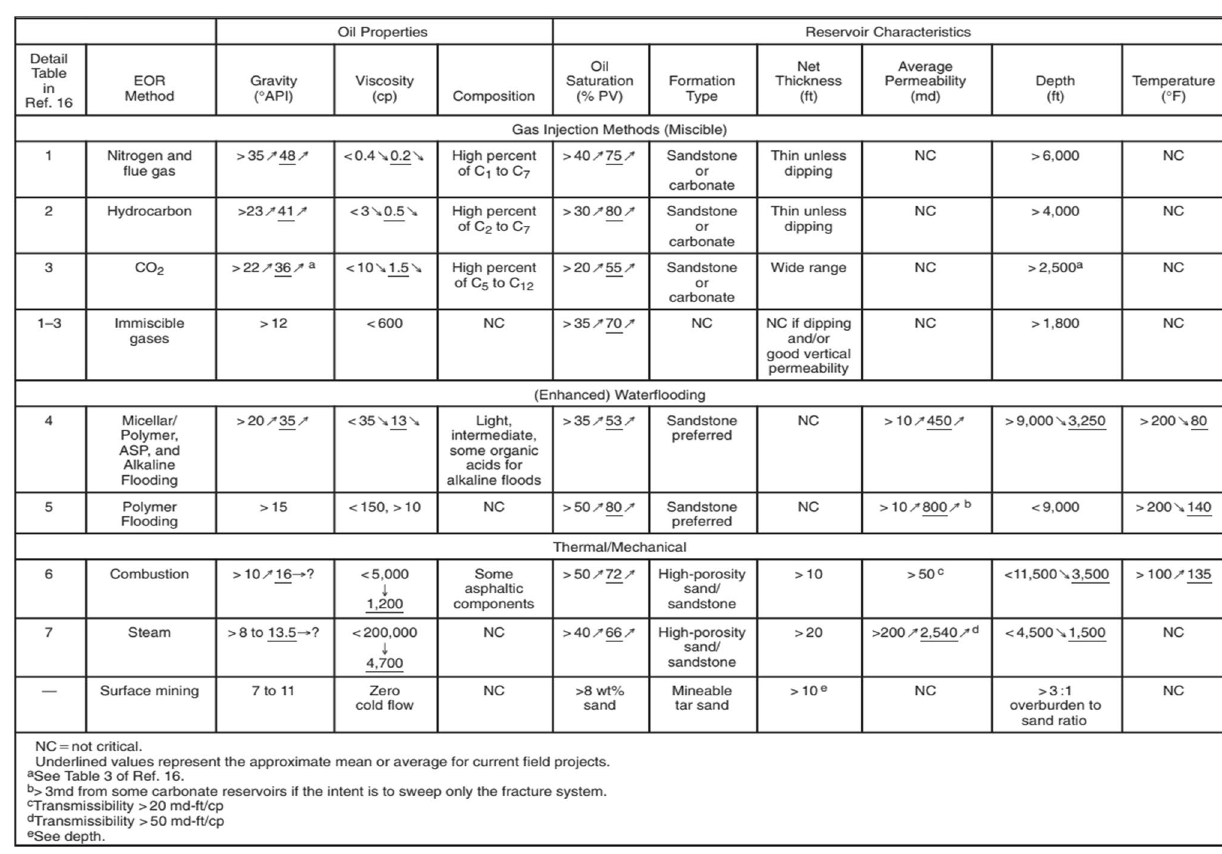
Fig. 4 Summary of screening criteria for EOR methods Taber et al. (1997)and Sheng